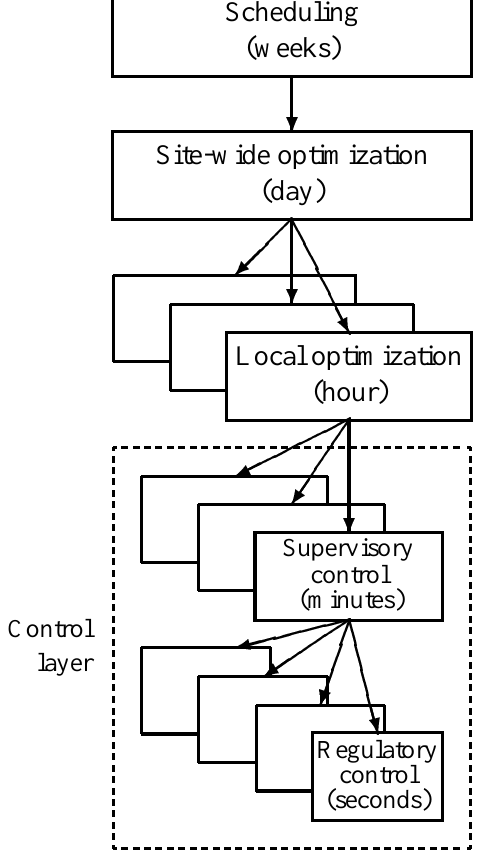
Figure 1. Typical control hierarchy in a chemical